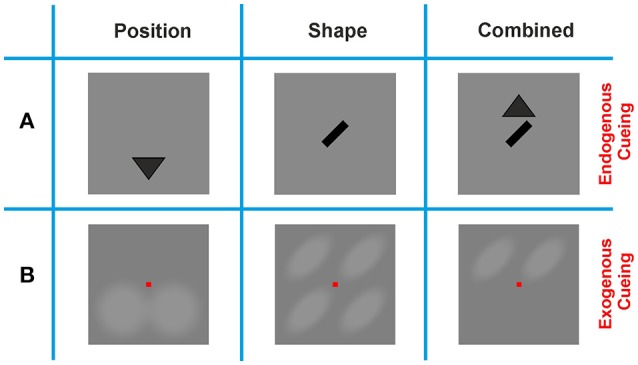
Cueing methods. (A) Endogenous cues provided the contour feature, or location information in a symbolic manner by presenting either a triangle indicating whether a contour would appear on the lower or upper half of the screen (Position cue), an oriented bar indicating the tilt of the contour (Shape cue), or a combination of these two cues (Combination cue). Position cues appeared either below or above the position of the fixation square, and Shape cues were centered in the middle of the screen. (B) Exogenous cues provided the same information in an explicit manner, by shading either the upper or lower section of the screen (Position cue), four oriented ovals at the possible locations where a contour could appear (Shape cue), or two oriented ovals at the possible locations where a contour could appear (Combination cue). Note that the scales of the Endogenous and Exogenous cues in this display are different: while Exogenous cues cover most of the stimulus display, Endogenous cues were much smaller and shown in the immediate vicinity of the fixation spot.